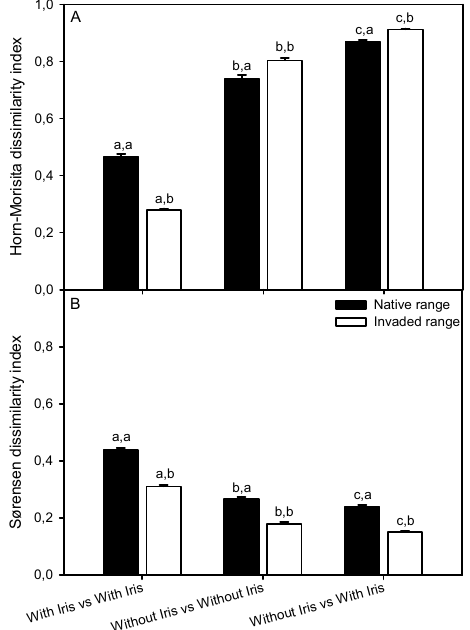
Figure 5. Horn–Morisita ( A ) and Sørensen ( B ) dissimilarity indices between plant communities with and without Iris pseudacorus in its native (Guadalquivir Estuary) and invaded (San Francisco Bay-Delta Estuary) distribution ranges. Different letters indicate significant differences between plant communities within each range (first letter) (Kruskal–Wallis test and Man–Whitney U-test, p < 0.05) and between ranges for the same plant community (second letter) (Man–Whitney U-test, p < 0.05). Values are mean ± SE ( n = 703–1521).